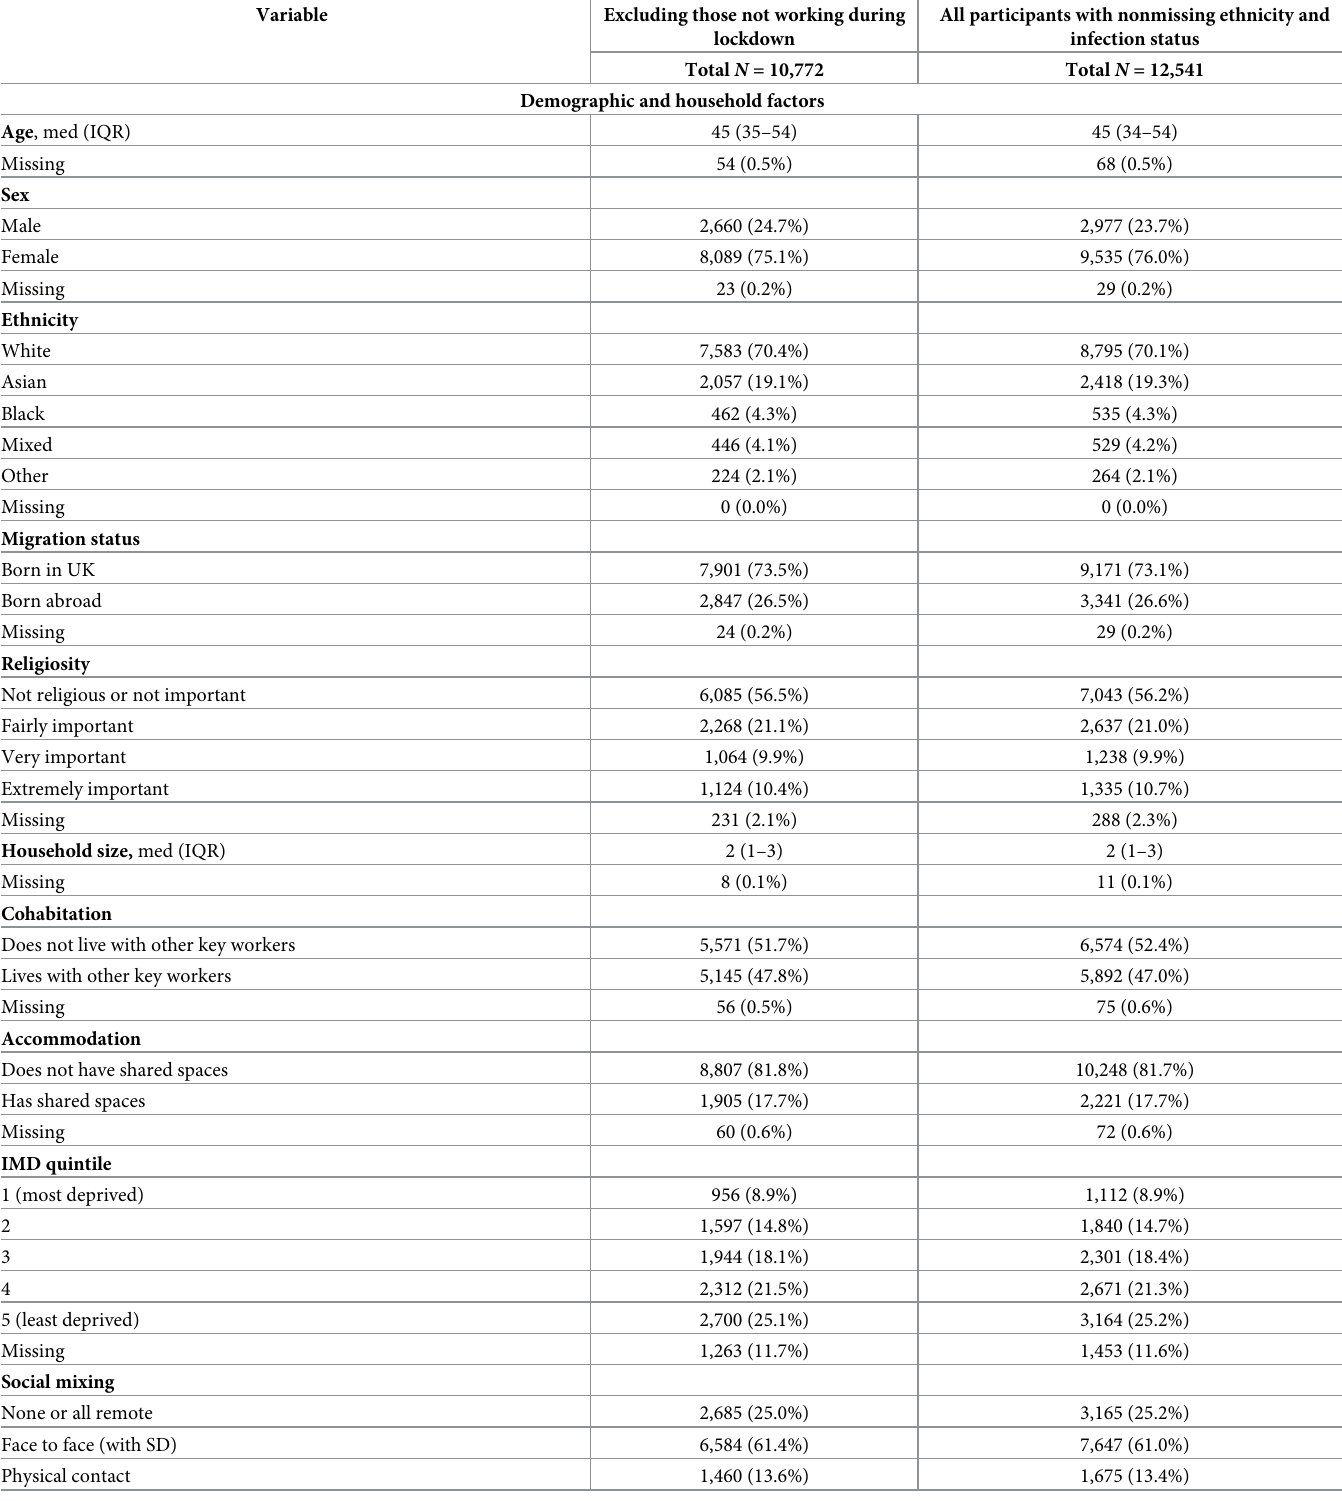
Table 1. Description of the 2 analysed